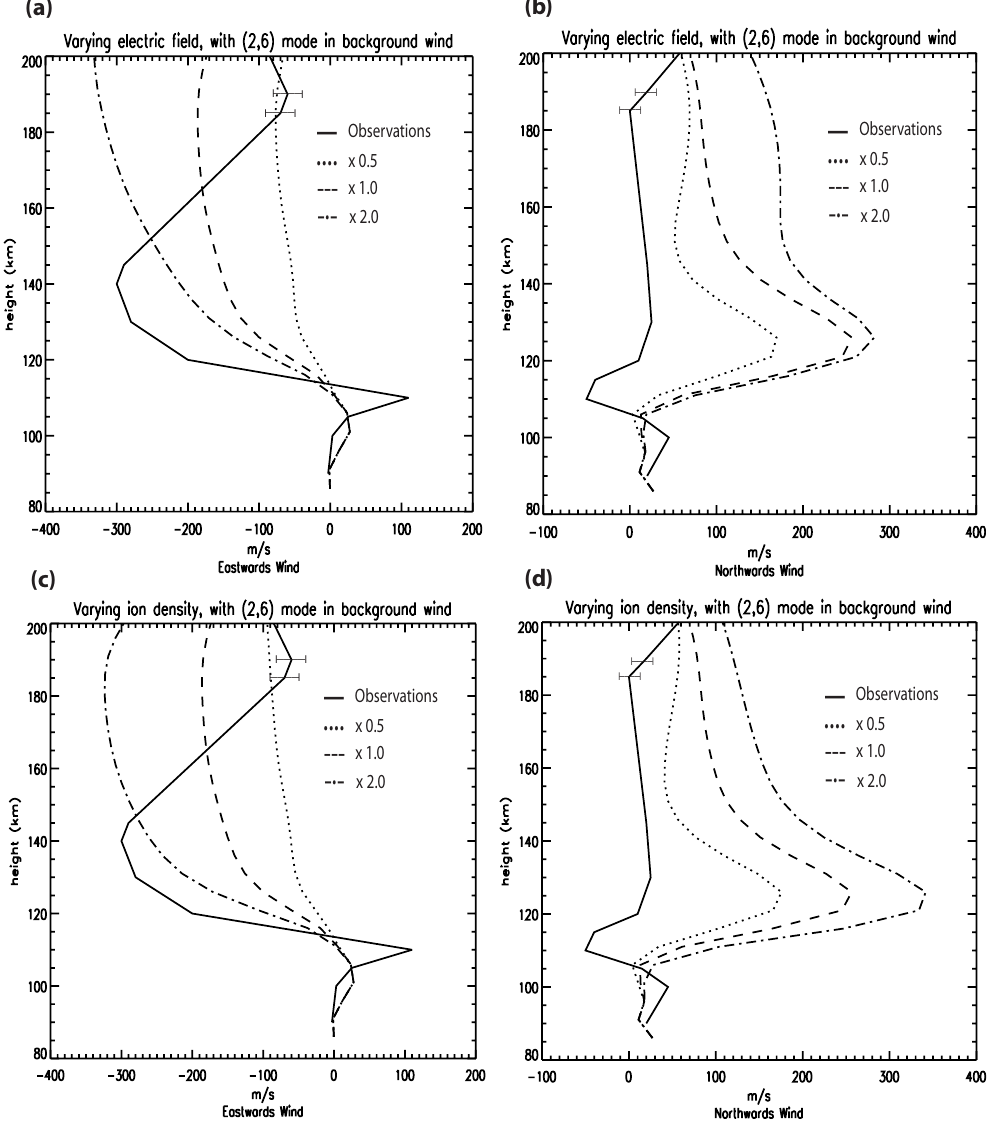
Fig. 8. (a) and (b) response of the neutral winds to varying electric field magnitude, with the (2,6) tidal mode in the background winds, (c) and (d) response of the neutral winds to varying ion density enhancement, with the (2,6) tidal mode in the background winds. The southern trail 28 February observations are included for